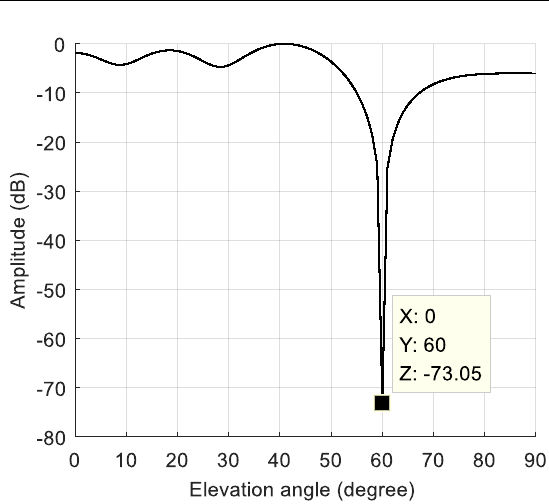
Figure 11. The null of the spatial filtering in the lower dynamic scene.